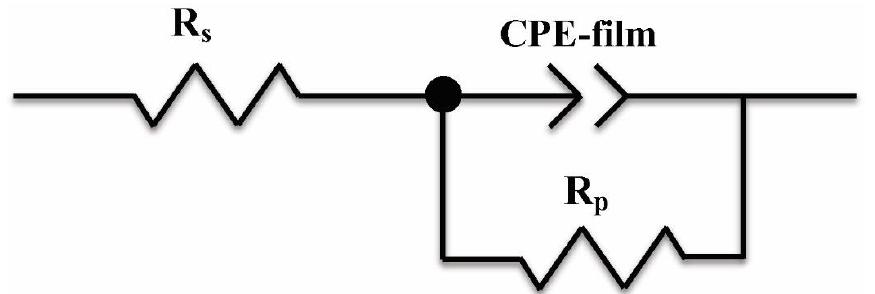
9 of 12 . Figure 9. EIS of the different samples ( a ) Nyquist curves ( b ) Bode phase ( c ) Bode impedance. To more accurately explain the results of EIS in detail, the equivalent electrical circuits are shown in Figure 10. The fitting results were shown in Table 3, in which R s represents the solution resistance; CPE-film is used instead of a pure capacitive, which is defined by admittance (Y 0 ) and power index number (n), and can be calculated by the formula (Y CPE ( ω ) = 1/Z CPE = Y 0 (j ω ) n ) [34]. R p represents charge transfer resistance. Under the condition of 10μm, it had the smallest CPE -film value and a largest R p value, where the CPE-film value was related to the corrosion area [35]. At the same time, the value of R p was positively correlated with corrosion resistance [32], indicating that it had the best corrosion resistance under the condition of 10 μm, which was consistent with the results obtained by the polarization curve and EIS. Refinement of grain size might be the main